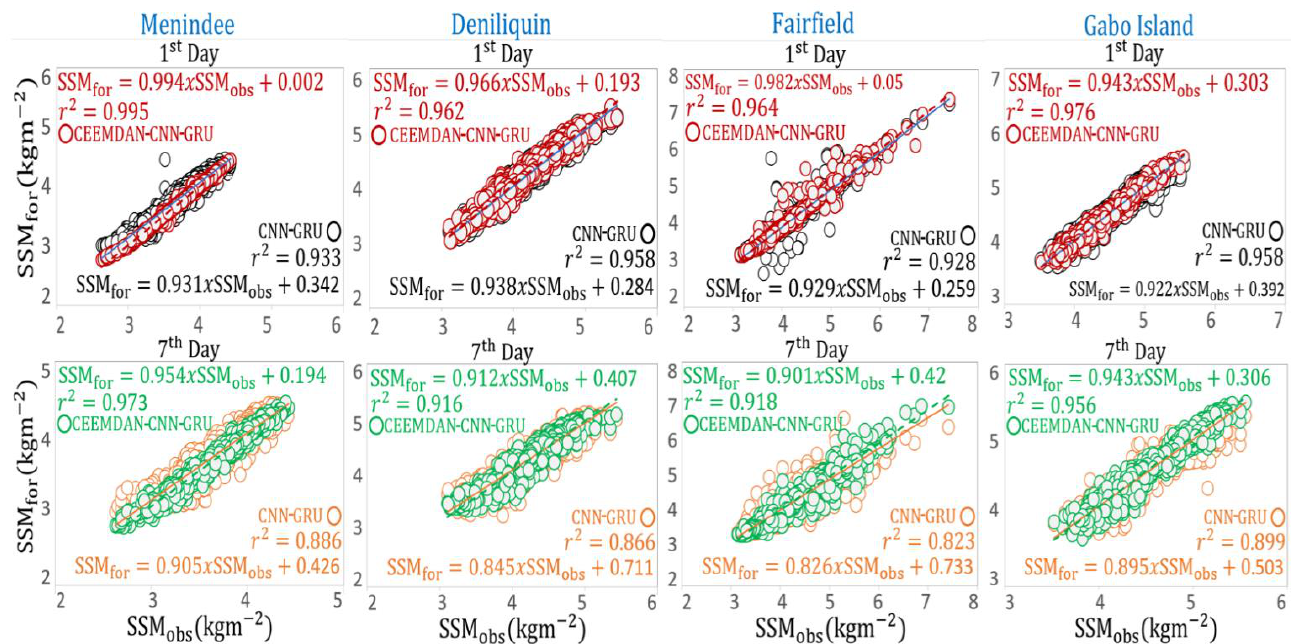
Figure 8. Scatter plot of the forecasted and observed SSM for Menindee, Deniliquin, Fairfield, and Gabo Island stations at different n th ( n = 1 and 7) day ahead. A least square regression line, y = mx + C , and coefficient of determination ( R 2 ) is shown in each sub-panel.